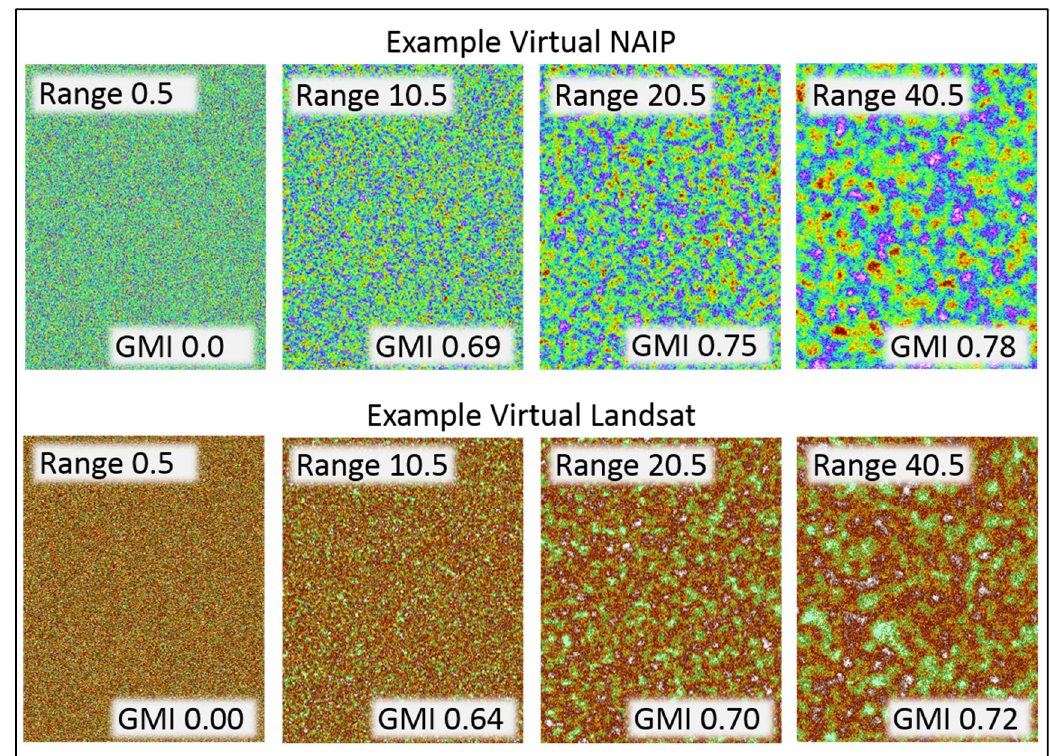
Figure 5. Subset of images created from average digital number (DN), sill, and nugget and maximum range values derived from NAIP and Landsat 8 imagery.